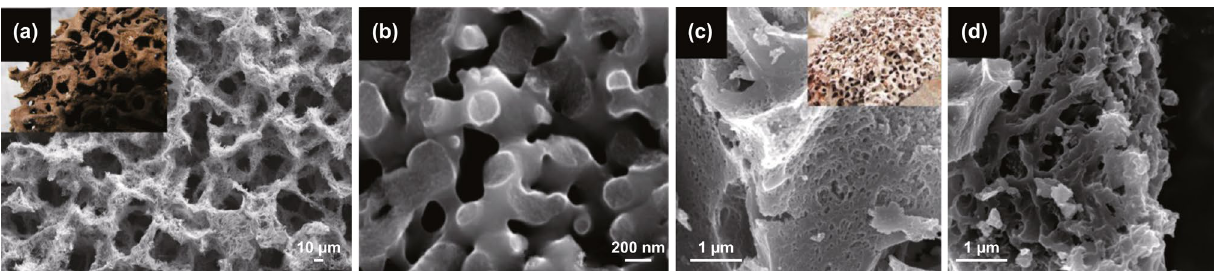
Fig. 11 a SEM image of ant-nest-like NiMoO 4 /CMS, inset is ant-nest. Reproduced with permission from Ref. [140]. Copyright 2018, Royal Society of Chemistry. b SEM image of carbon ‐ based ant-nest-like structures. Reproduced with permission from Ref. [141]. Copyright 2019, Wiley. c SEM image of ant-nest-like ANHPC and d SEM image MnO 2 /ANHPC. Reproduced with permission from Ref. [142]. Copyright 2018, ACS